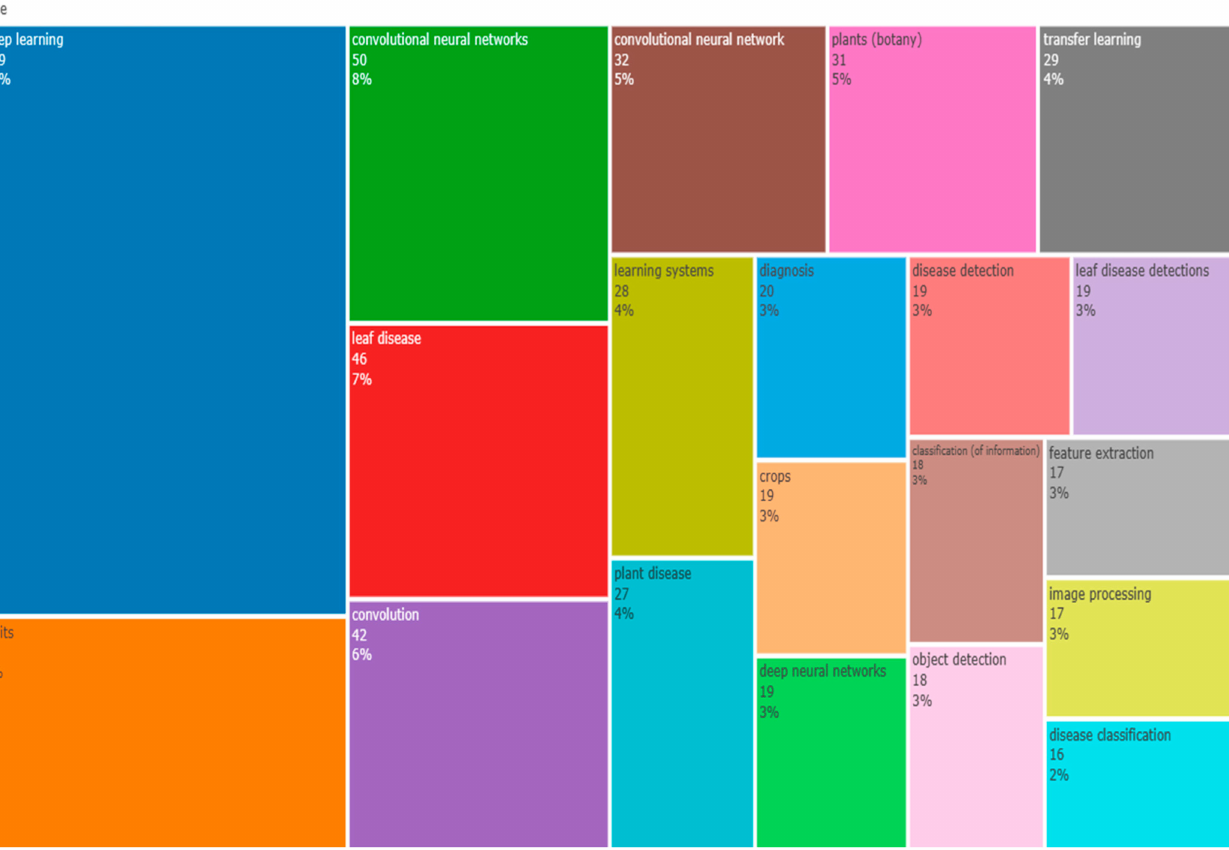
Figure 21. World TreeMap (Source: Author elaboration using